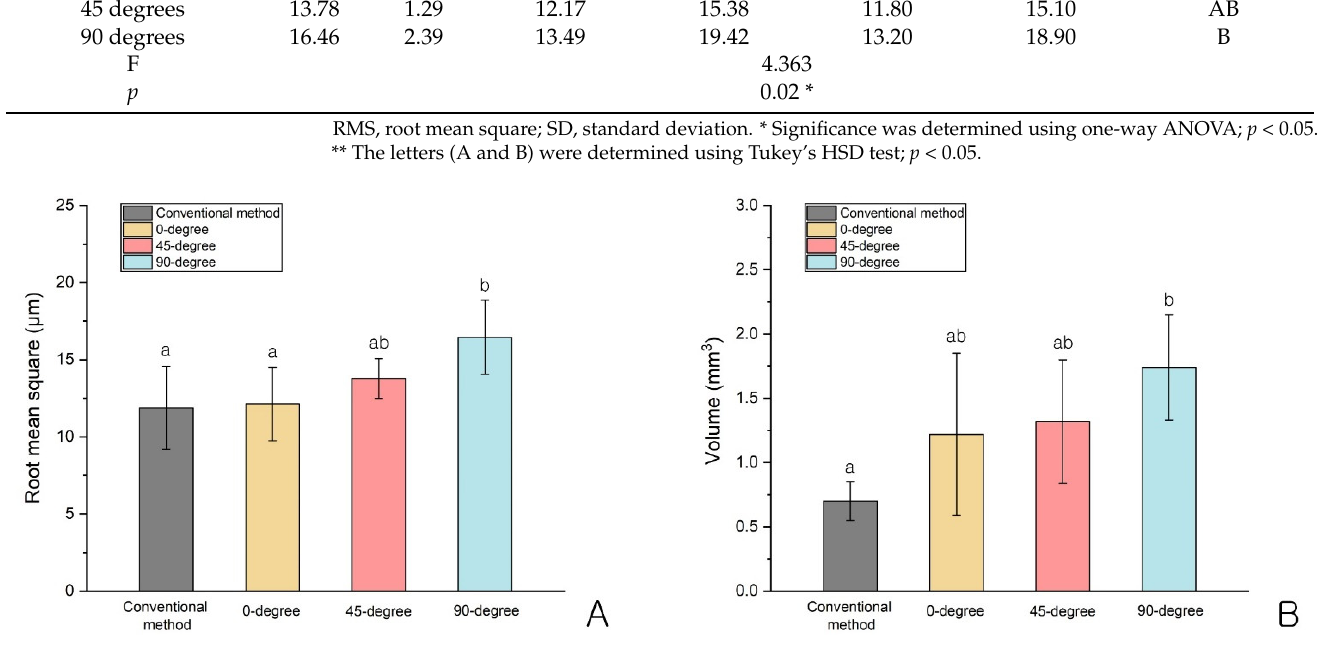
Table 3. Comparison of the wear of interim crowns fabricated according to build angle (RMS (µm)).